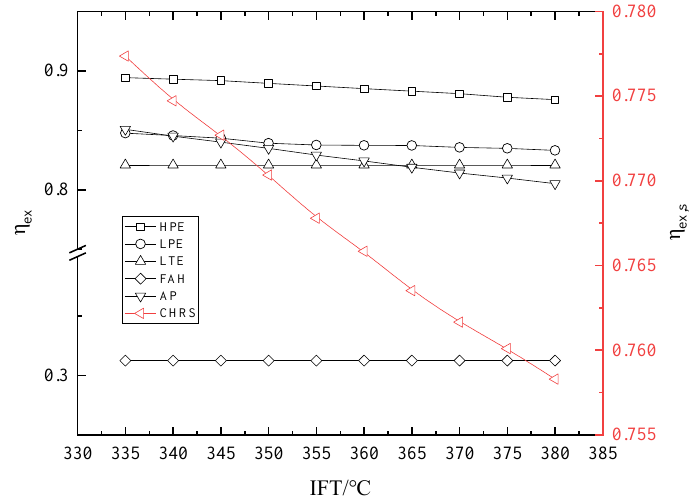
Figure 6. Exergy efficiency of heat exchangers and CWHRS under different IFT. Figure 6. Exergy e ffi ciency of heat exchangers and CWHRS under di ff erent